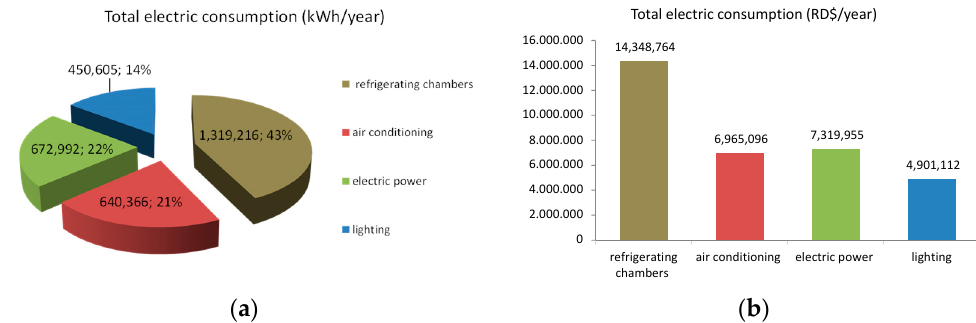
Figure 2. ( a ) Distribution of total electric consumers ( b ) Distribution of total electric costs by consumers.